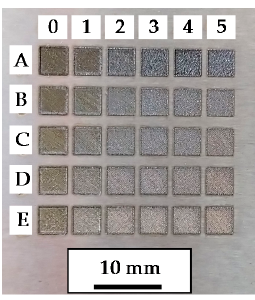
Figure 3. Parameter tests for obtaining the best LBM conditions (Test Part 1).